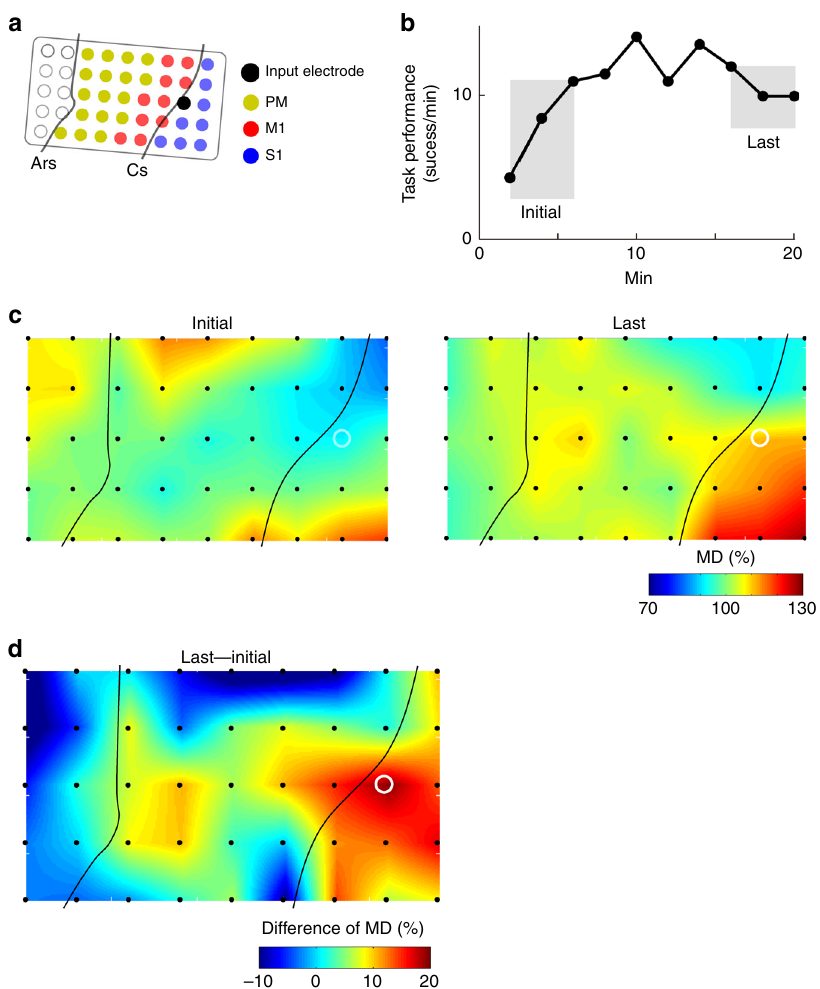
Fig. 5 Learning in conjunction with an ACMC in the somatosensory cortex. a The ACMC input electrode is represented by the black circle in S1. Electrical stimuli were applied to the fl exor carpi ulnaris (FCU) muscle. b Time course of task performance over 20 min. The initial and last time intervals used in c are indicated in grey. c Topographic map of the MD during the initial and last phases. d Changes in the spatial distribution of the MD of high-gamma activity in the initial phase compared with the last phase. The white open circle represents the input electrode ( c – d ). Similar results were obtained from fi ve independent experiments using different pairs of electrodes from S1 and muscles ( N = 1 monkey [Monkey M], n = 5 sessions, cf . Figs. 2c, d and 3e, Supplementary Figs. 6 and